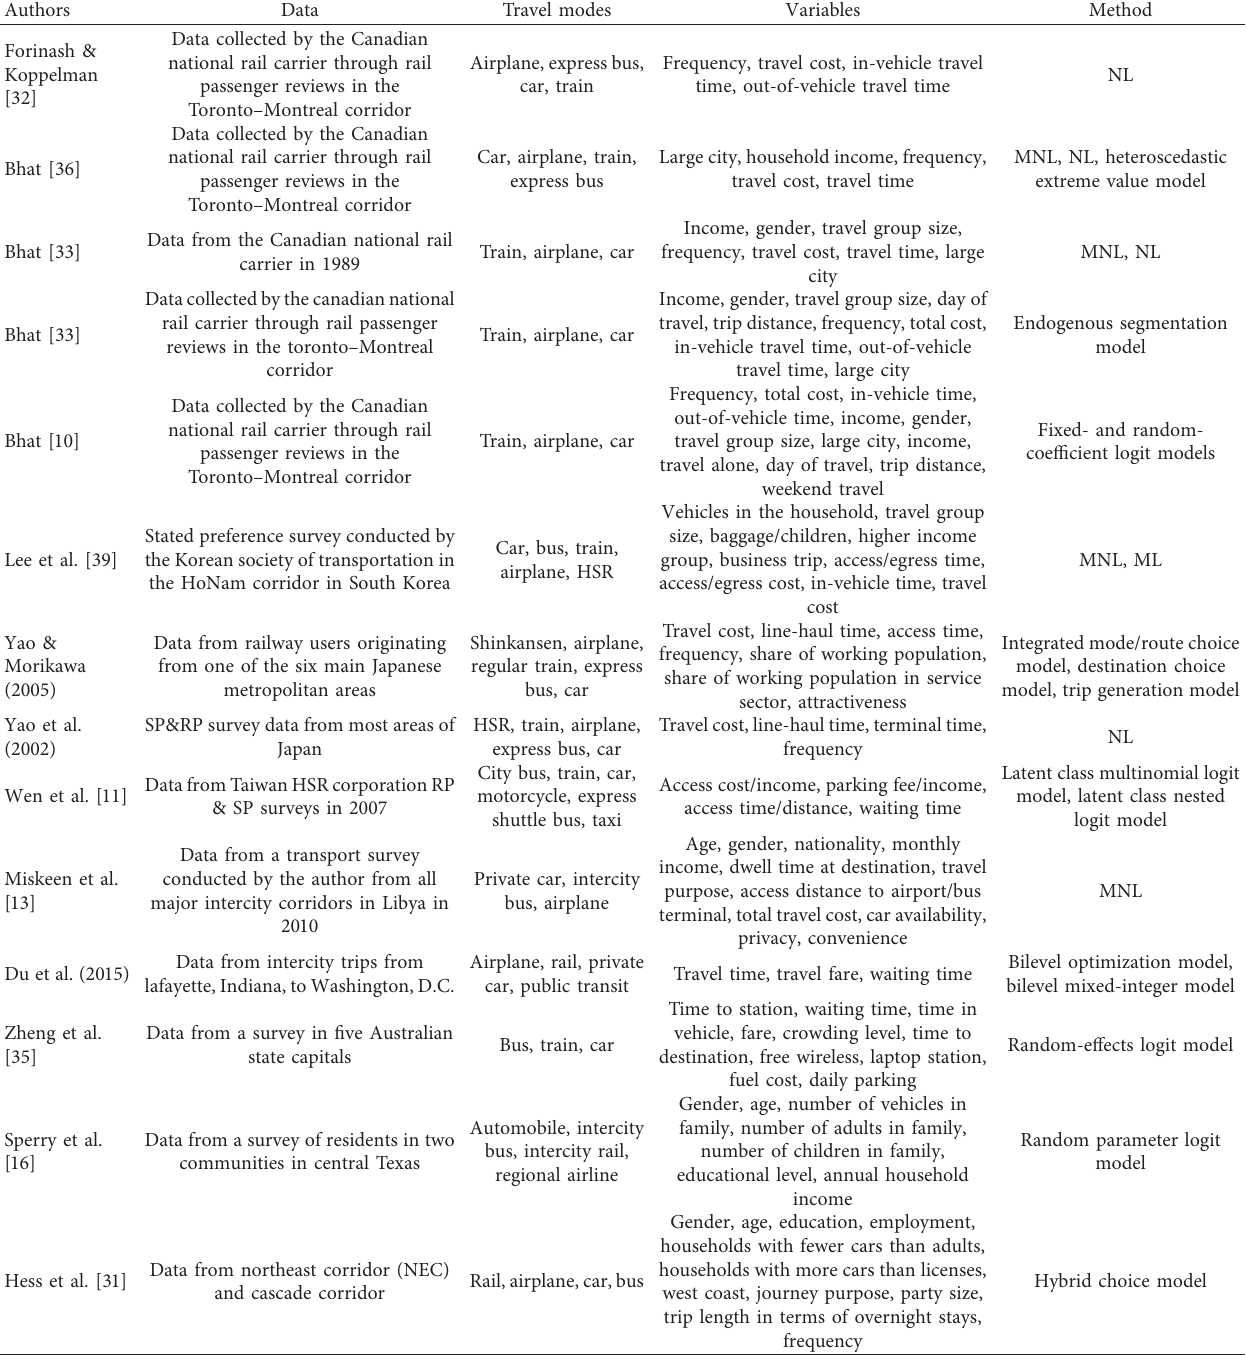
Table 1: Summary of previous studies on intercity travel mode